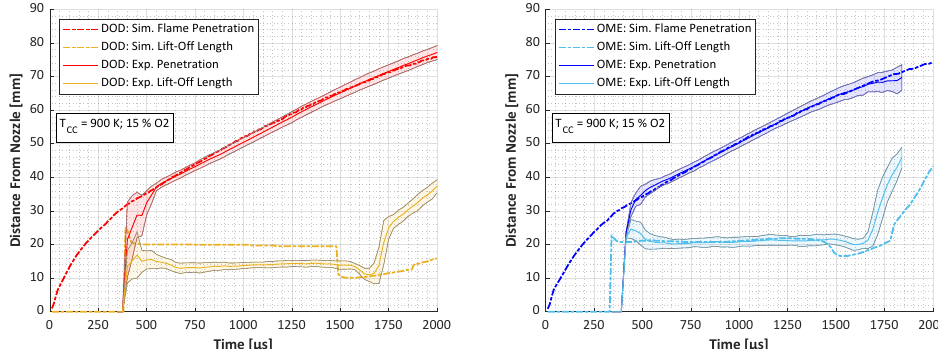
Figure 11. Conti3L: Spray lift-off length and penetration for reactive conditions: Ar : T CC = 900 K and 15% O 2 . ( left ) Dodecane. ( right )